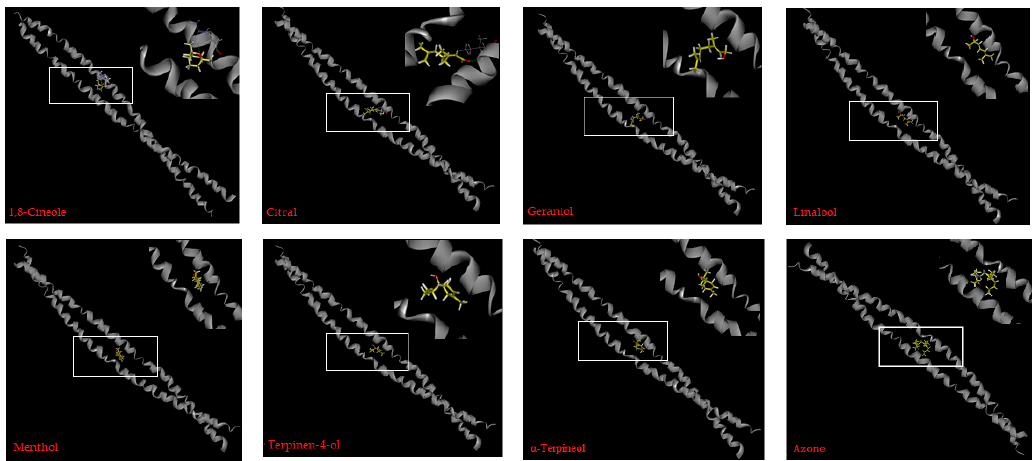
Figure 7. The stable complexes of oxygen-containing terpenes and keratin.